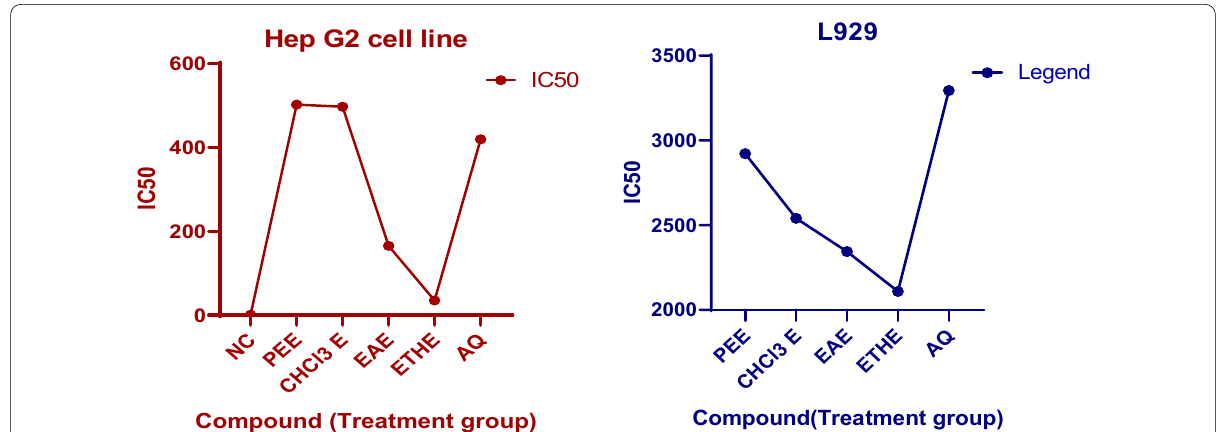
Fig. 1 IC50 determination using MTT assay for C. pluricaulis : HepG2and L929 cell line IC50 value were calculated based on MTT assay, graph showing the IC50 values of various leaves extracts